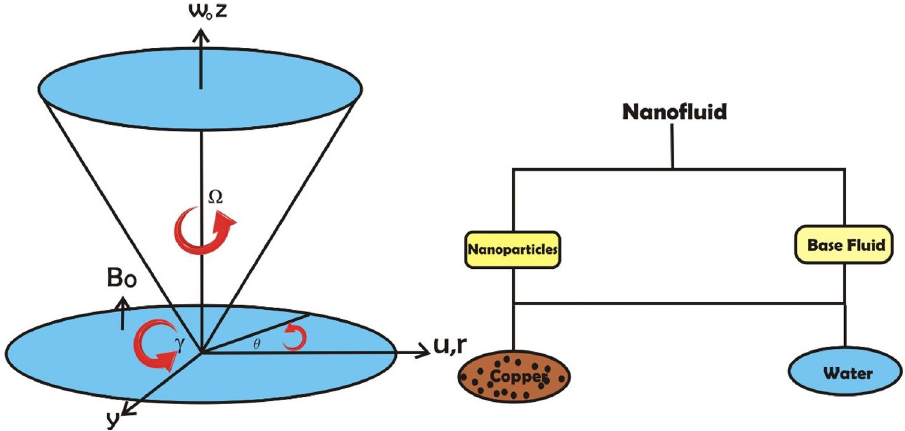
Figure 1. Flow chart of the flow